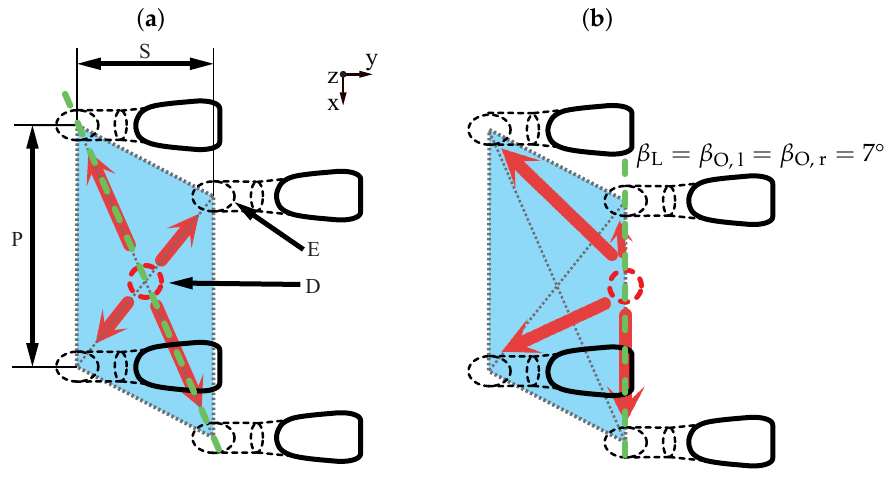
Figure 3. ( a ) Arrangement of each impingement cooling hole to the effusion cooling holes. Red arrows show theoretical exit paths and distance to the next effusion cooling hole. The blue parallelogram shows the wetted area before the coolant is ejected. ( b ) Misaligned setup MALO05 . Cut planes for later evaluation shown in